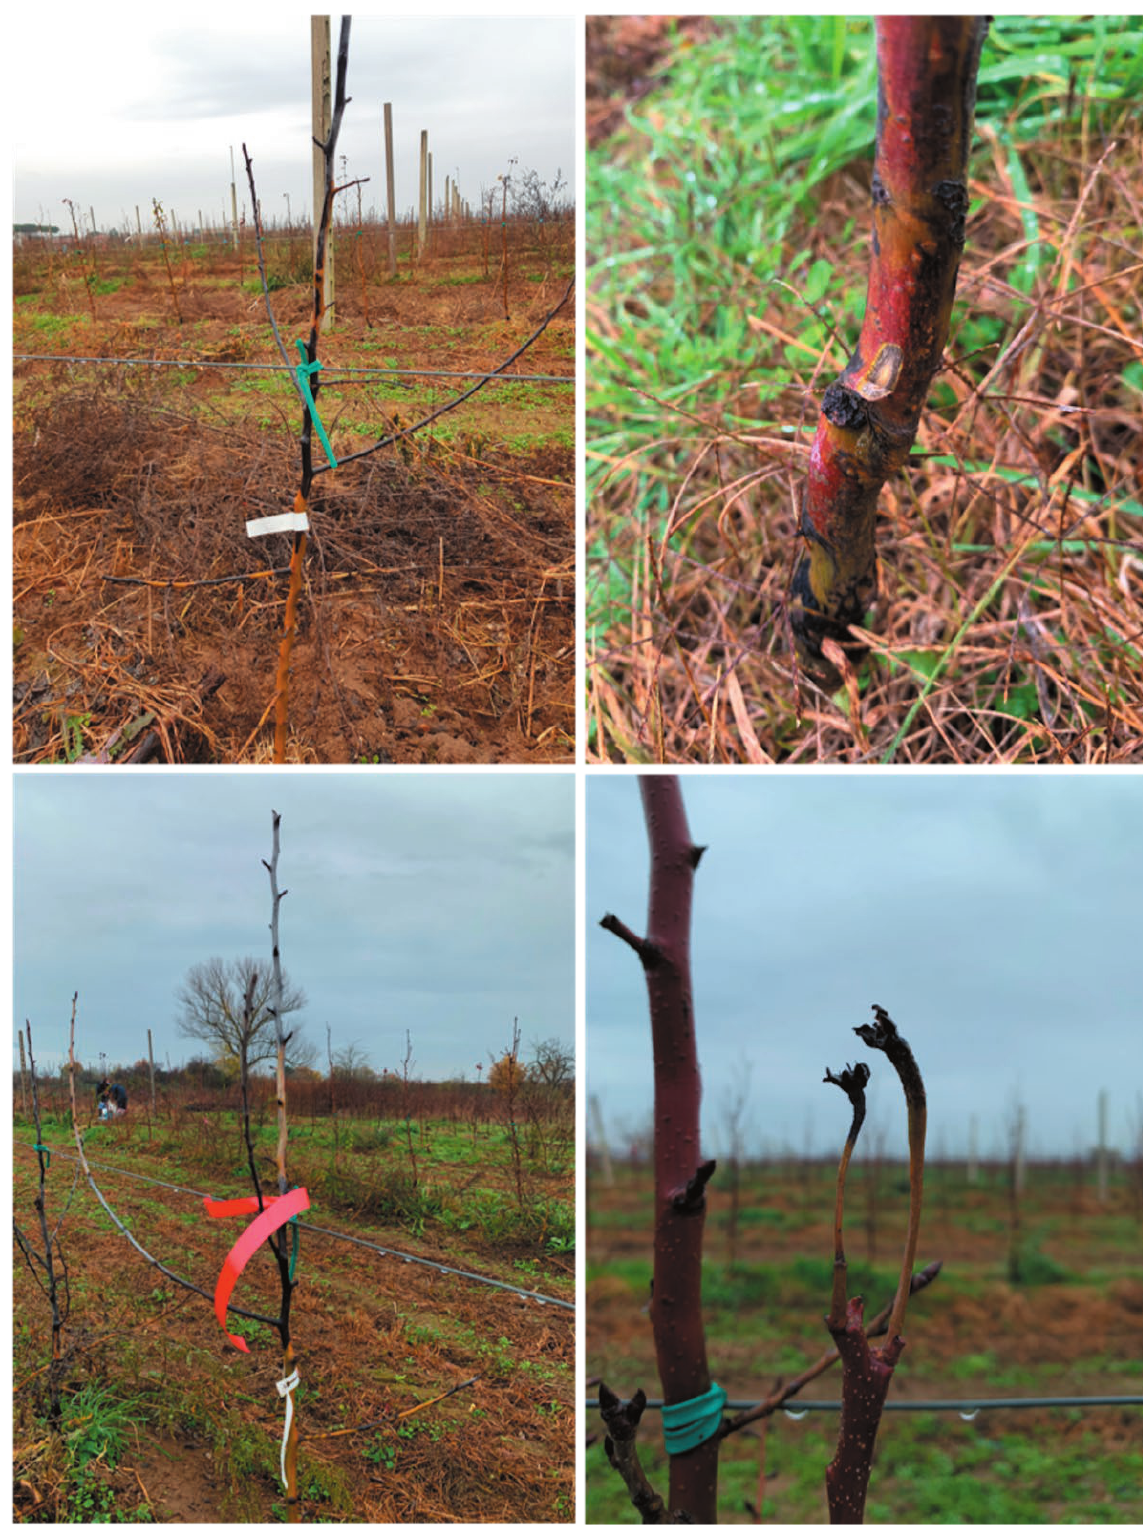
Figure 1. Symptoms of shoot blight and stem canker on symptomatic Pyrus communis ‘Williams’ and ‘Red Williams’ plants sampled during the